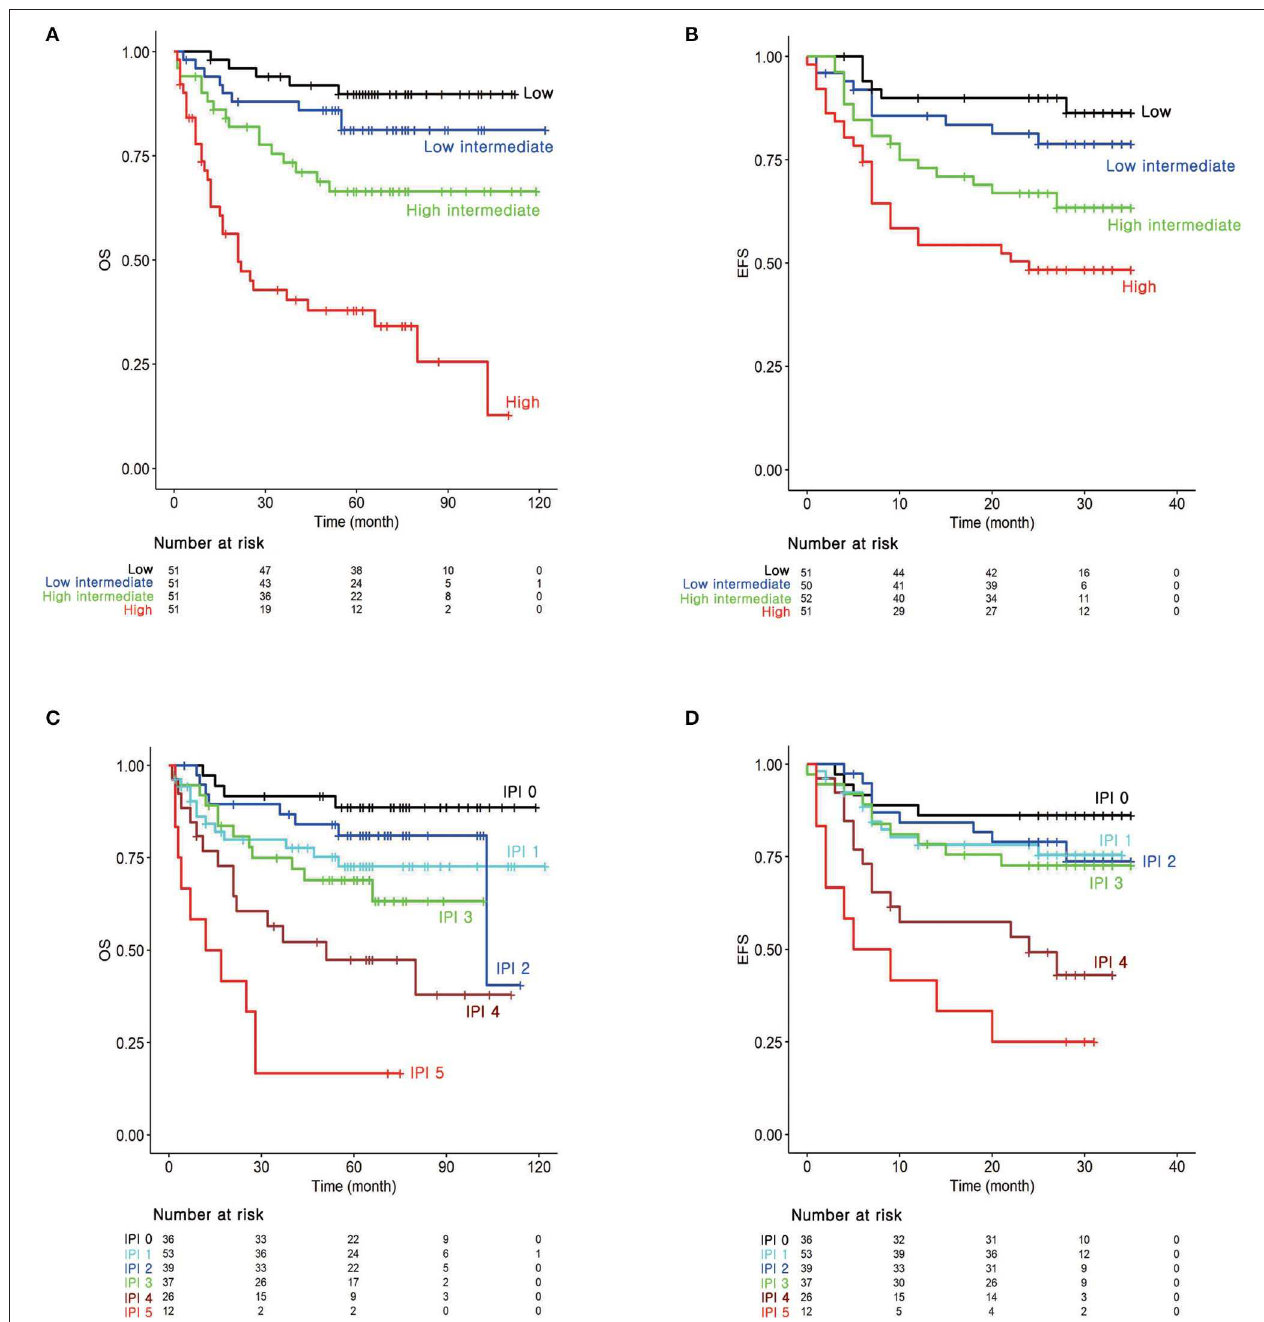
FIGURE 1 | Survival analysis according to the risk groups. Kaplan–Meier survival curves for (A) overall survival (OS) and (B) 2-years event-free survival (EFS24) according to the prognostic index from the MFP model. (C) Kaplan–Meier survival curves for OS and (D) EFS24 according to the IPI.